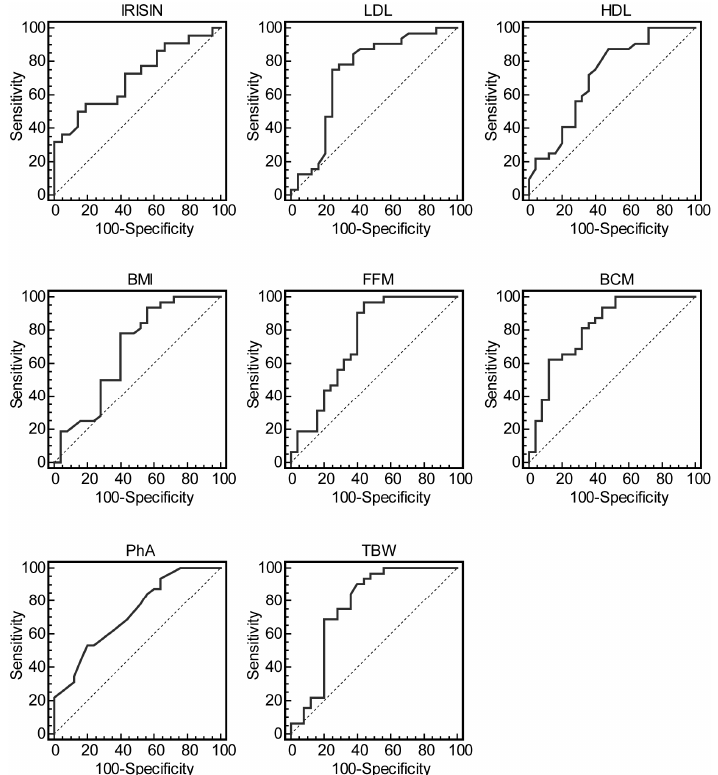
Figure 5. Receiver operating characteristic (ROC) curves of irisin, LDL, HDL, BMI, FFM, BCM, PhA, and TBW as predictors of vigorous-intensity physical activity. Graphic evaluation of irisin,